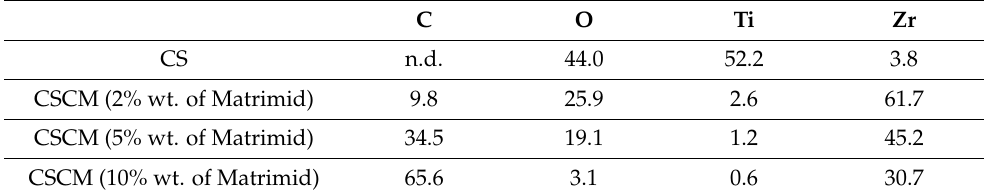
Table 2. Environmental scanning electron microscopy-Energy dispersive X-ray spectrometry analysis; composition (wt.%) of the CS and CSCM.